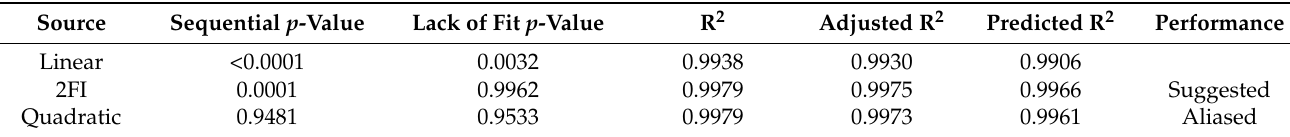
Table 5. Fit summary of the models.